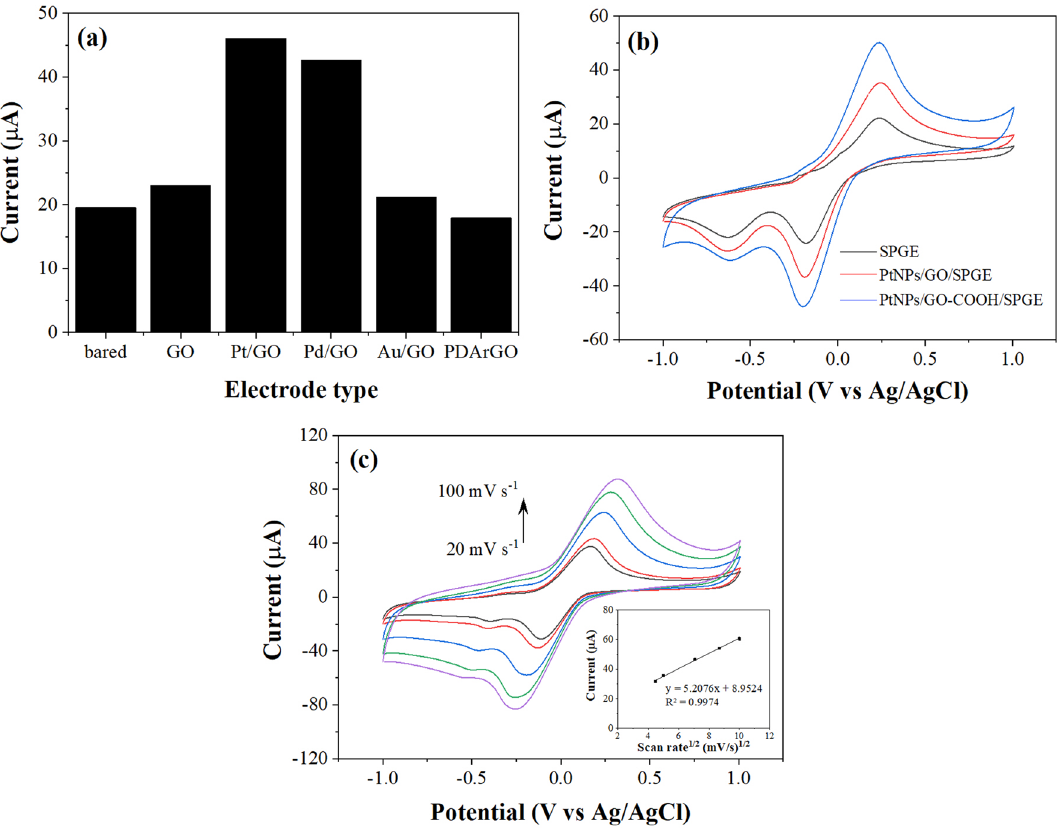
Figure 2. ( a ) Anodic current responses of various modified SPGEs, ( b ) CVs of SPGE, PtNPs/GO/SPGE, and PtNPs/GO-COOH/SPGE in 10 mM PBS solution pH 7.4 containing 3 mM hydroquinone at a scan rate of 100 mV s −1 , and ( c ) CVs of hydroquinone at different scan